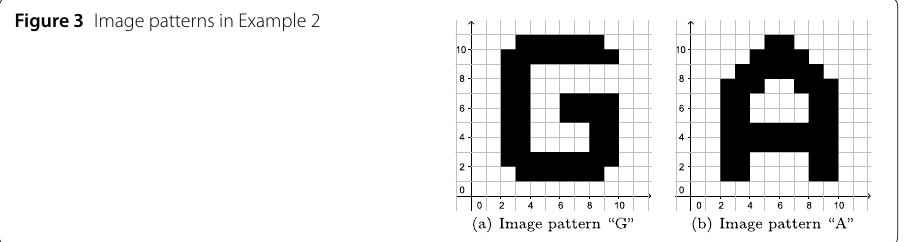
Figure 3 Image patterns in Example